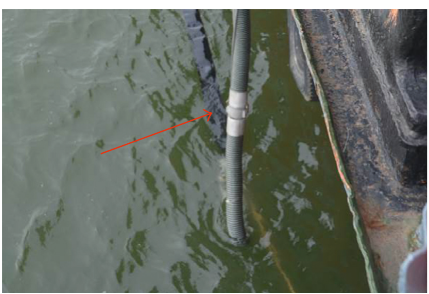
Figure 43: Plug-in joint part.